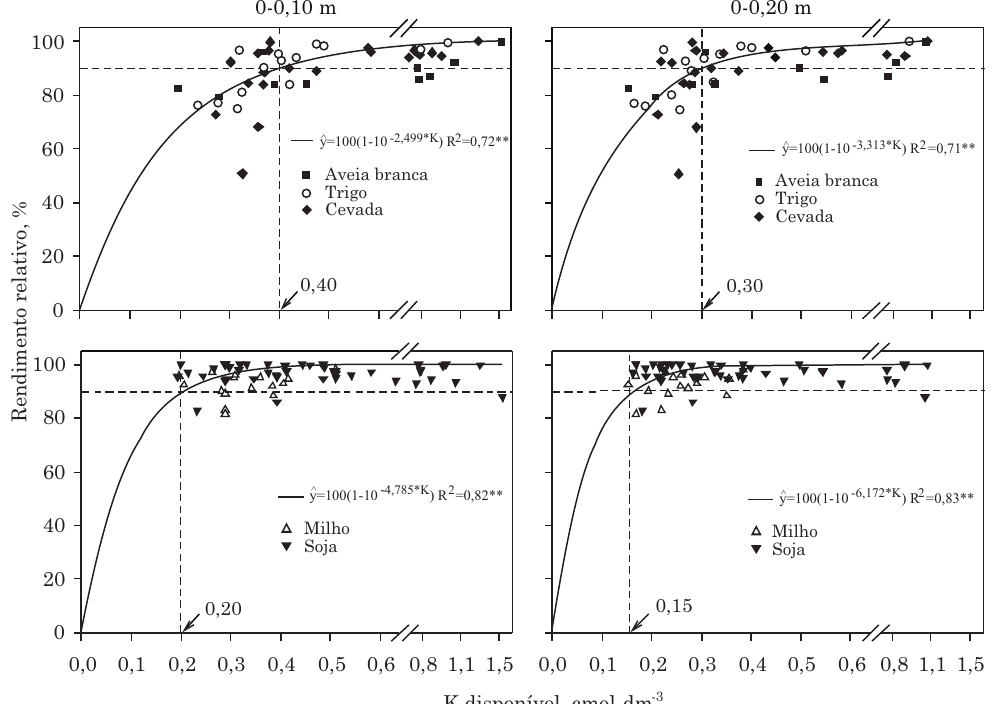
Figura 5. Rendimento relativo de aveia branca, trigo e cevada (a, b) e milho e soja (c, d) em razão do potássio disponível (Mehlich-1), nas camadas de 0-0,10 e 0-0,20 m de solos em plantio direto na região Centro-Sul do